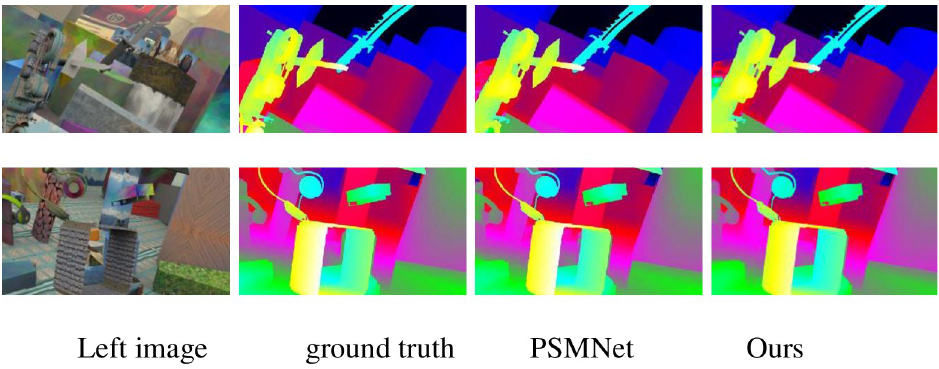
in this study exceed that of the reference network PSMNet. As listed in the fifth row of Table 3, the 3 px error rate on the KITTI 2015 validation set decreases from 1.98 to 1.78, and the end